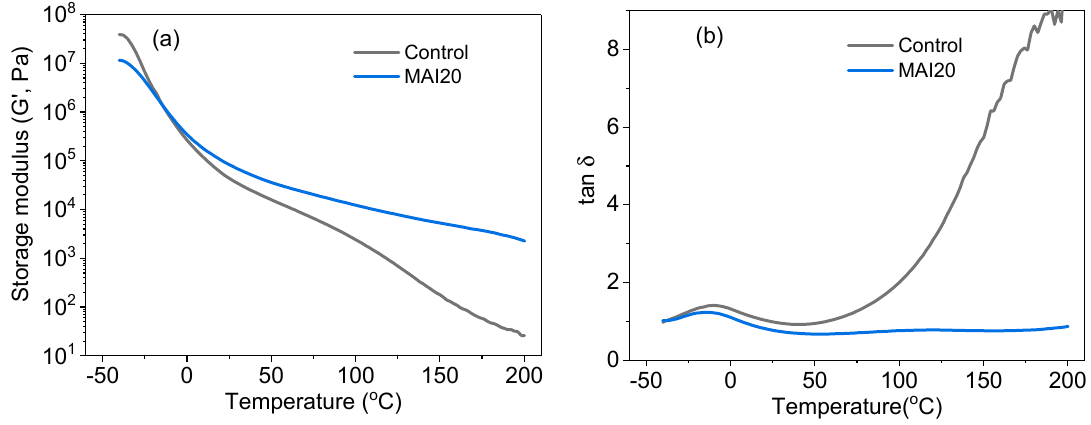
Figure 6. Storage modulus (G’) ( a ) and tan δ ( b ) of control PSA and SPSA (MAI20).